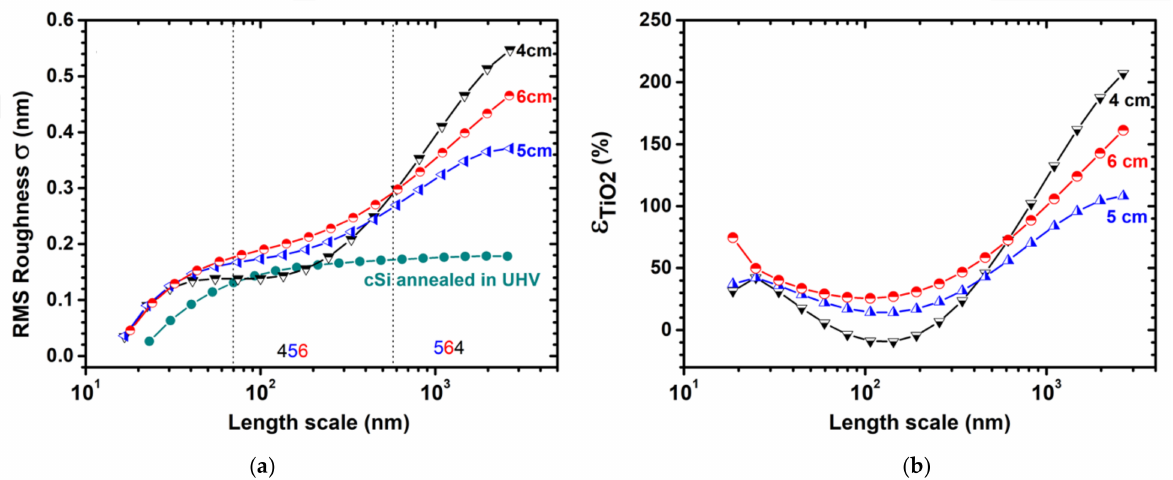
Figure 5. ( a ) TiO 2 thin film roughness calculated using radial PSD versus the length scale corresponding to d TS of 4, 5, and 6 cm. The c-Si substrate roughness is represented in dark green. ( b ) TiO 2 thin film roughness variation relative to (100) Si substrate for the same d TS values, versus the length